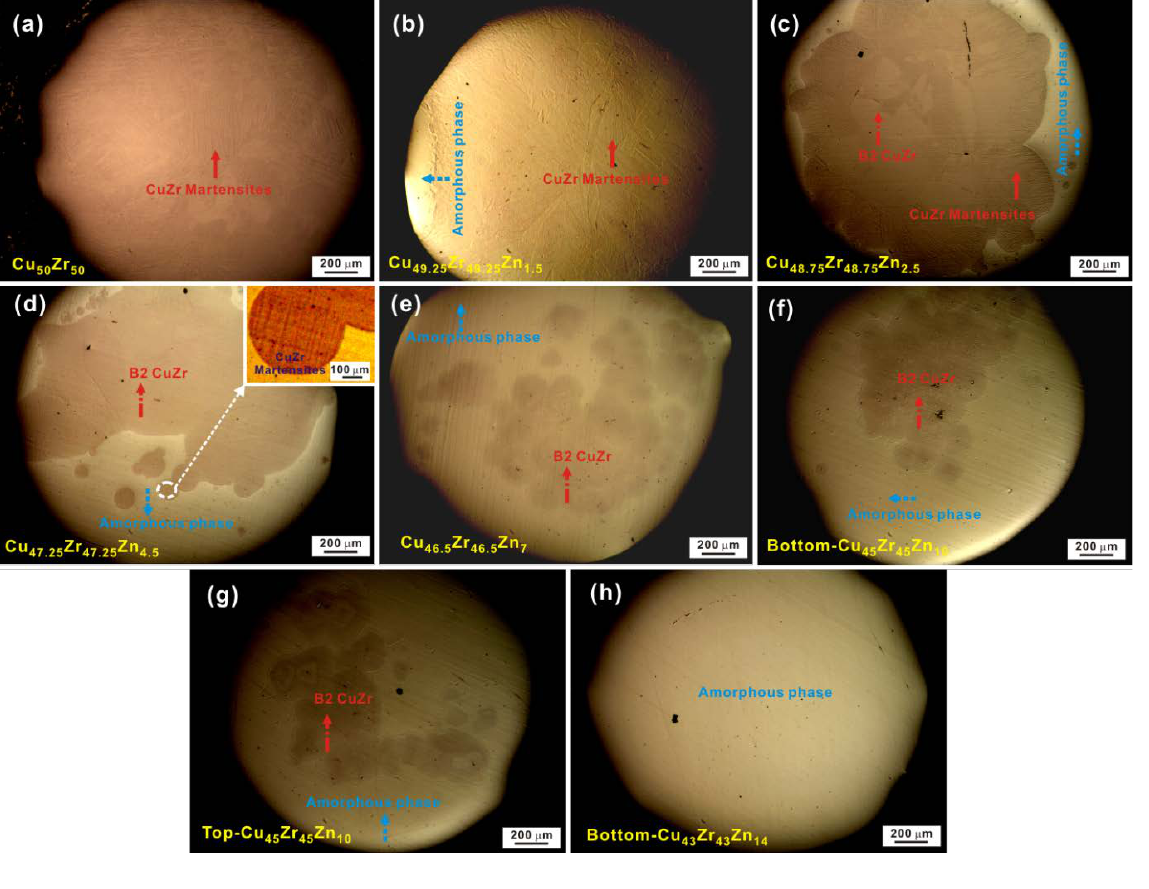
Figure 2. OM pictures of the as-cast (Cu 0.5 Zr 0.5 ) 100− x Zn x ( x = ( a ) 0; ( b ) 1.5 at. %; ( c ) 2.5 at. %; ( d ) 4.5 at. %; ( e ) 7 at. %; ( f , g ) 10 at. %; and ( h ) 14 at. %) rods with a diameter of 2 mm [39]; Inset: martensitic plates within B2 CuZr